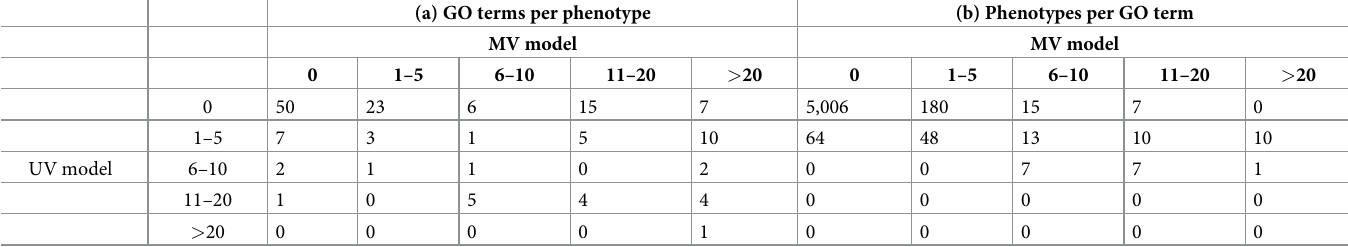
Table 2. Co-enrichment counts compared across the UV and MV models. (a) Number of GO terms co-enriched with each IMPC phenotype; e.g., there are 23 pheno- types that have 0 GO terms enriched for the UV model but which have between 1 and 5 GO terms enriched for the MV model. (b) Number of IMPC phenotypes co- enriched with each GO term; e.g., there are 180 GO terms that have 0 phenotypes enriched for the UV model but which have between 1 and 5 phenotypes enriched for the MV